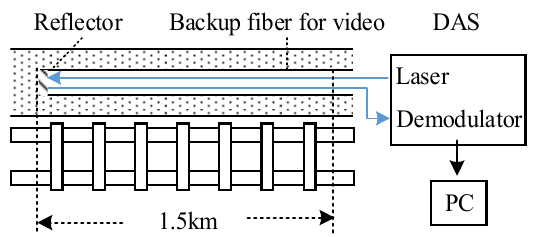
Figure 2. DAS deployment. The backup optical fiber for video is used as a sensor for DAS, which means that additional installation is not needed.